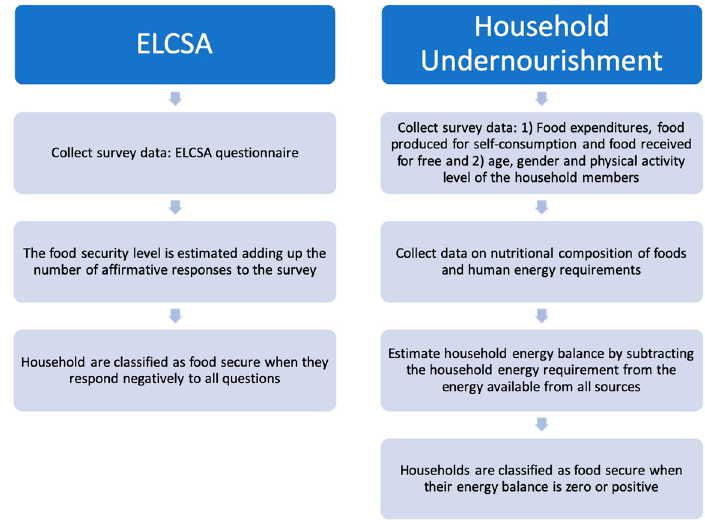
Figure 1. Estimation procedure of ELCSA and household undernourishment food security indicators. ELCSA, Latin American and Caribbean Food Security Scale.